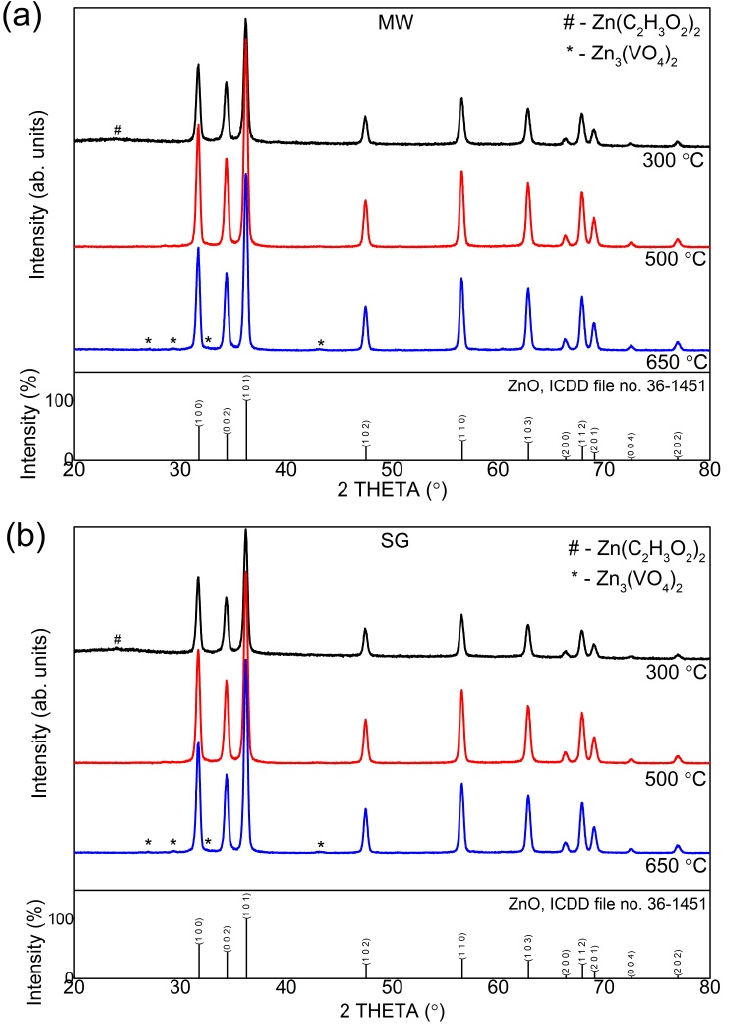
Figure 3. XRD patterns of the thermally treated samples prepared by: ( a ) microwave assisted sol–gel method (MW), ( b ) sol–gel method (SG).